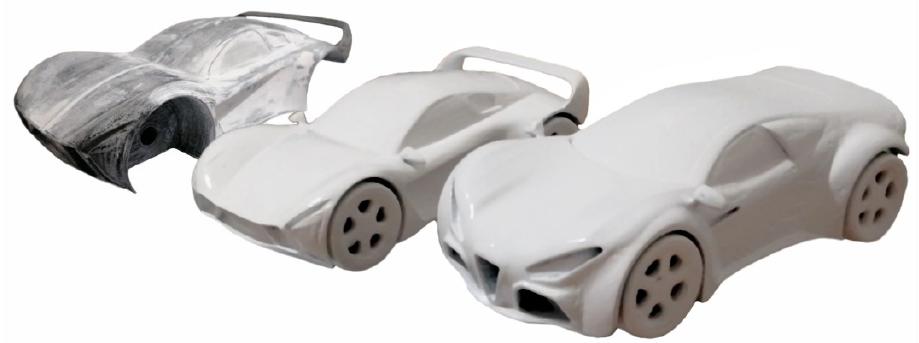
Figure 37. Mockup model in the post-process phase ( left ) and completed mockup models ( right ).